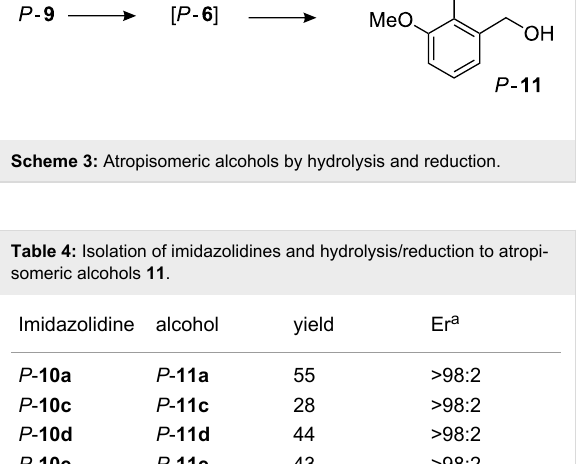
Figure 1: X-ray crystal structure of 9a . X-ray data has been deposited with the Cambridge Crystallographic Data Centre: deposition number 693530.